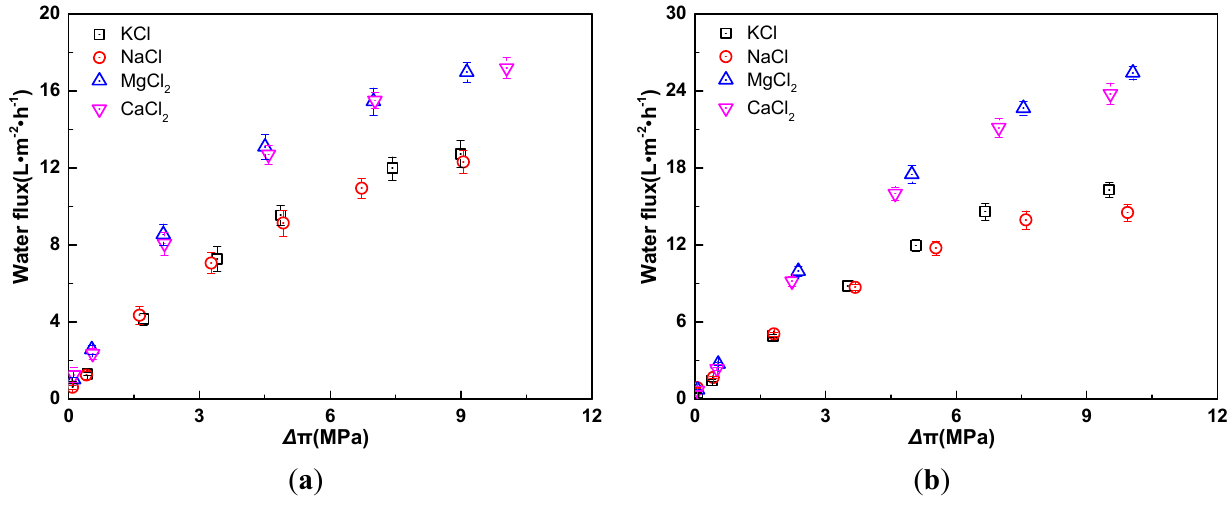
Figure 5. Relationship of water flux and effective osmotic pressure difference for four draw solutes in AL-DS mode ( t = 25 °C). ( a ) C pressure difference refers to the effective values after correction for the effect of